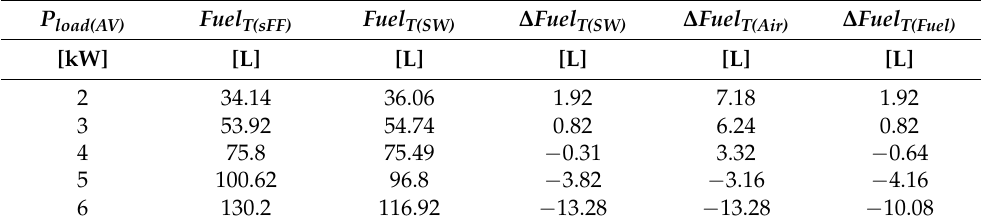
Table 4. Fuel economy for the first load profile using different P load(AV) values.